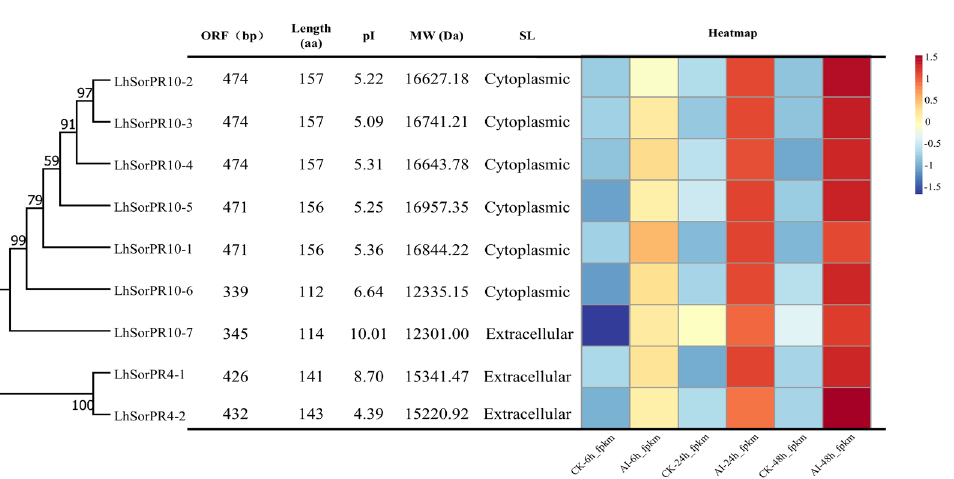
Figure 3. Analyses of the structure and expression of LhSorPR genes. From left to right, they are the phylogenetic relationships, protein sequence analysis and hierarchical clustering of gene-expression data of nine LhSorPR genes. The phylogenetic tree was constructed by MEGA 7.0. The number of amino acids, molecular weight (MW), and theoretical pI (isoelectric point) were evaluated using the ProtParam tool. A heat map between the AI and CK treatments at three stages of infection. The horizontal direction indicates expression at 6 h, 24 h and 48 h for the treatment and control. The longitudinal direction indicates nine LhSorPR genes. The data were FPKM values extracted from previously obtained second-generation transcriptome data (log2 transformed) and the color scale as shown on the right. AI, after inoculation; CK, control; FPKM, fragments per kilobase of transcripts per million mapped reads.